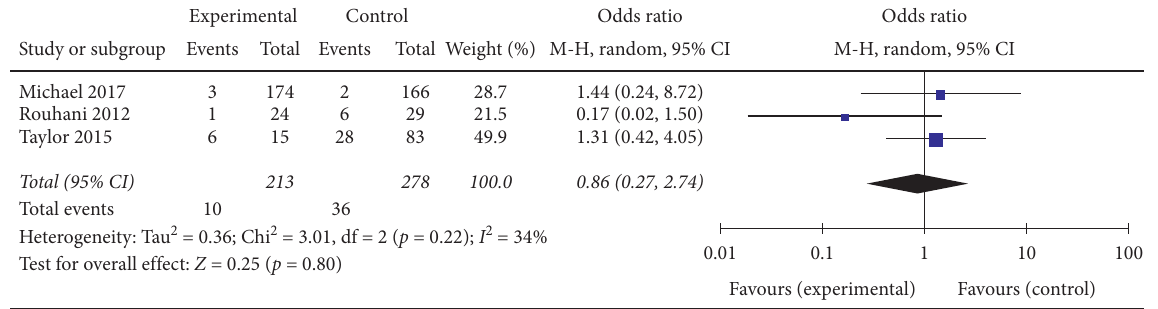
Figure 6: Malreduction.